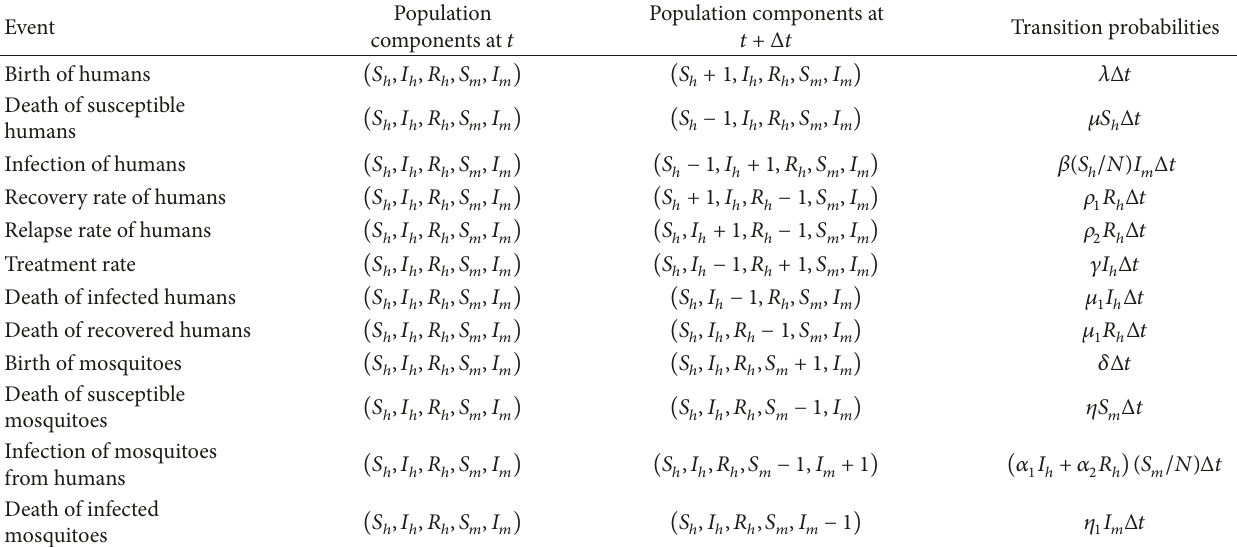
Table 1: State transitions and rates for the CTDSGWbp malaria